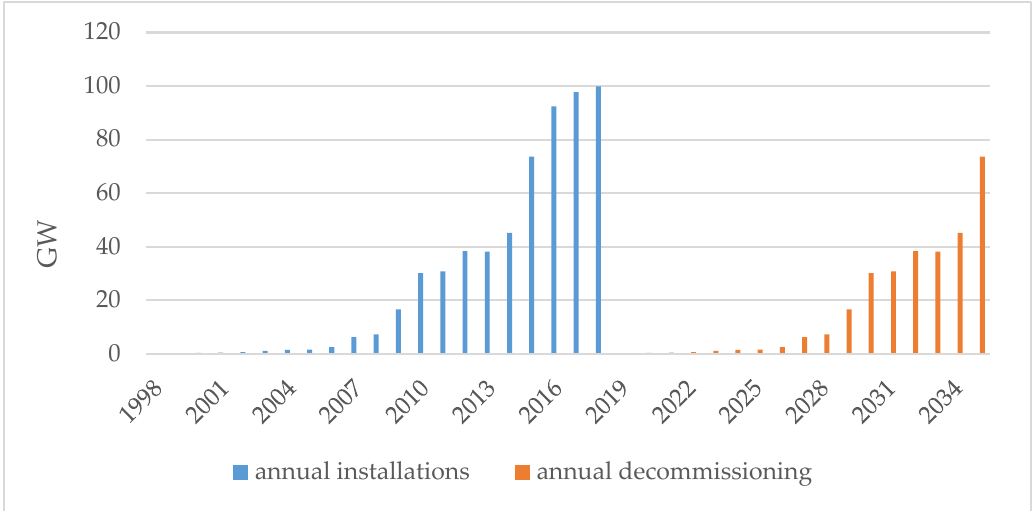
Figure 1. Historical development of annual new grid-connected photovoltaic (PV) installations (in GW) and anticipated decommissioning until 2035. Source: based on [19].